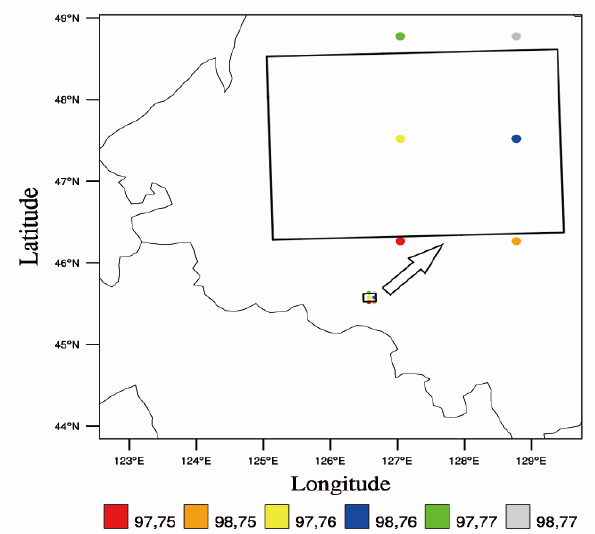
Figure 9. Position of the flight area (area in the black rectangular box) and the six grid points (colored circles. The grid points are named with a pair of numbers in the simulated area. The two numbers represent the position in the west ‐ east and south ‐ north directions, respectively.).